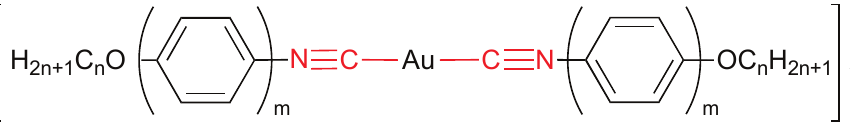
Figure 8. One alkoxy chain cationic mesogens. X = PF